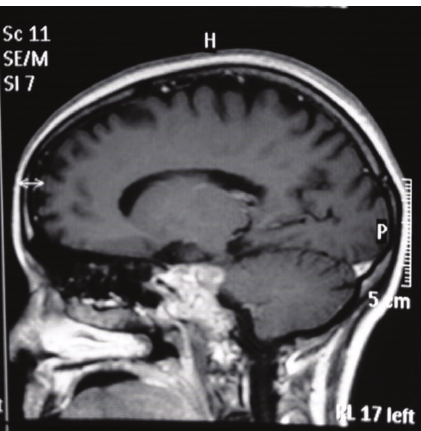
Figure 1: Sagittal section of the brain without contrast showing the clival lesion.